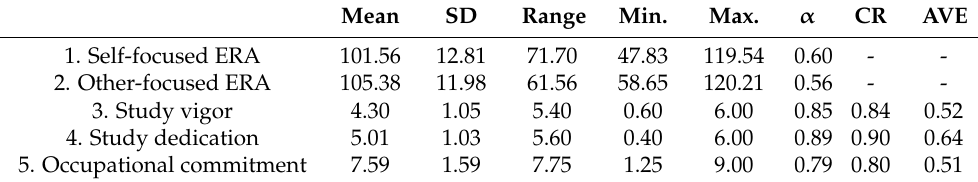
Table 1. Descriptive statistics of constructs derived from the questionnaire survey. Mean SD Range Min.